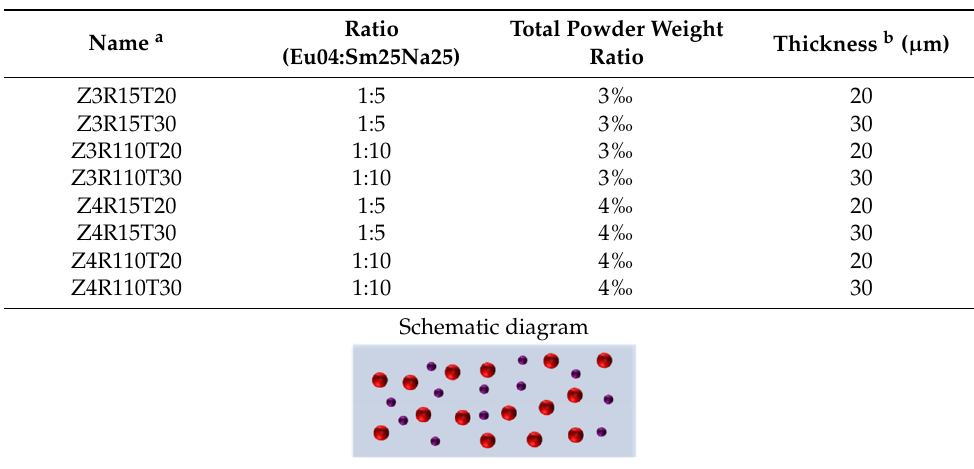
Table 4. The name of the polymeric luminescent coatings that were directly mixed with two phosphors.